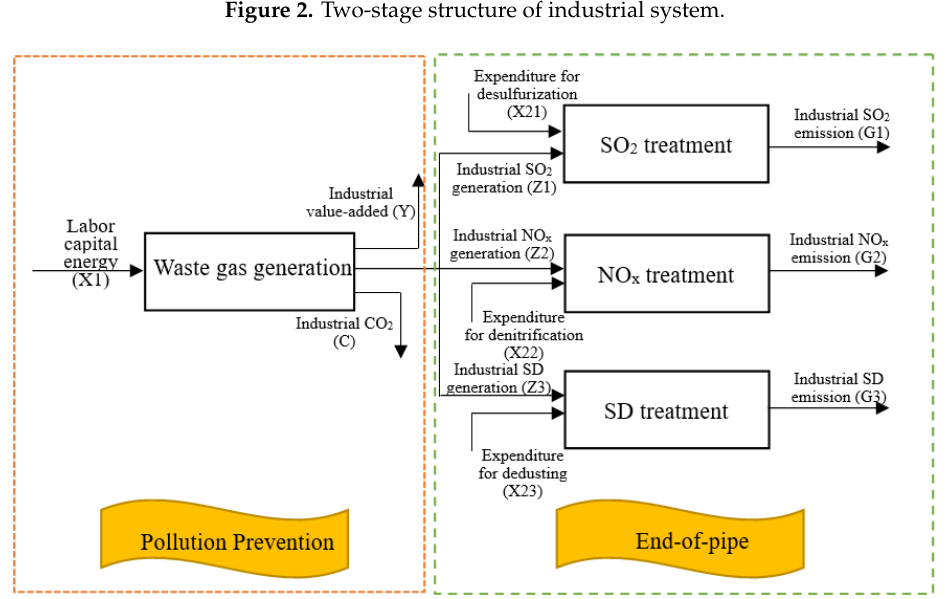
Figure 3. Pollution prevention and end-of-pipe treatment of industrial system. SD indicates Soot and Dust.